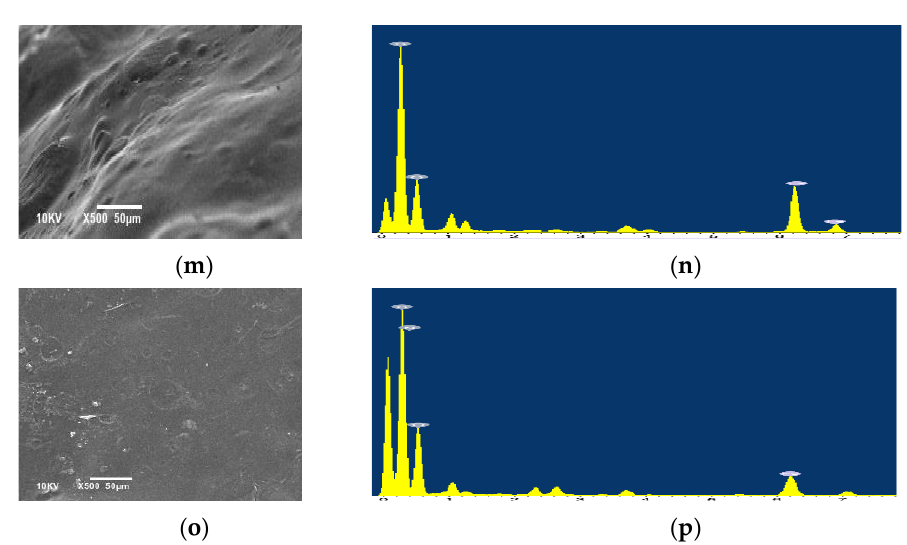
Figure 5. Typical SEM images and EDX spectra of cast iron coupons coated with ( a , b ) PVA, ( c , d ) PVA/PANI, ( e , f ) PVA/GO-COOH, and ( g , h ) PVA/PANI/GO-COOH. SEM images and EDX spectra of cast iron coupons coated with ( i , j ) PVA, ( k , l ) PVA/PANI, ( m , n ) PVA/GO-COOH, and ( o , p ) PVA/PANI/GO-COOH after 7 days of exposure to 3.5 wt.% NaCl.